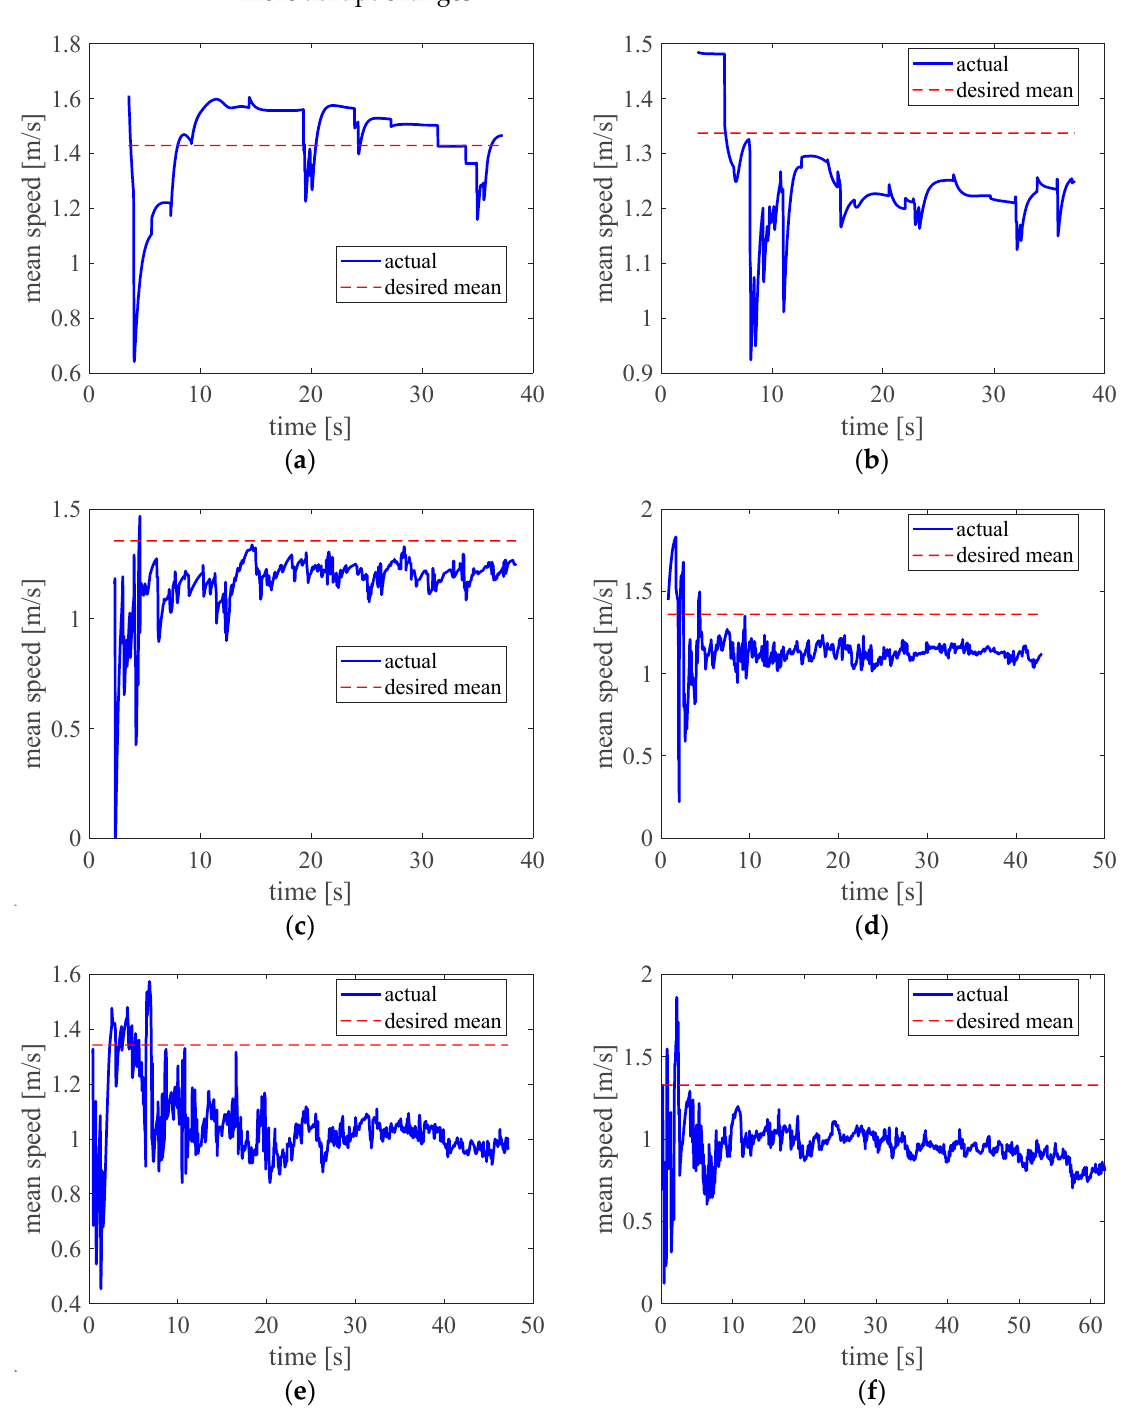
Figure 5. The mean speed of real-time evacuating persons on the bridge. ( a ) 0.1 pedestrians/m 2 , ( b ) 0.2 pedestrians/m 2 , ( c ) 0.5 pedestrians/m 2 , ( d ) 0.8 pedestrians/m 2 , ( e ) 1.0 pedestrians/m 2 , ( f ) 1.5 pedestrians/m 2 .